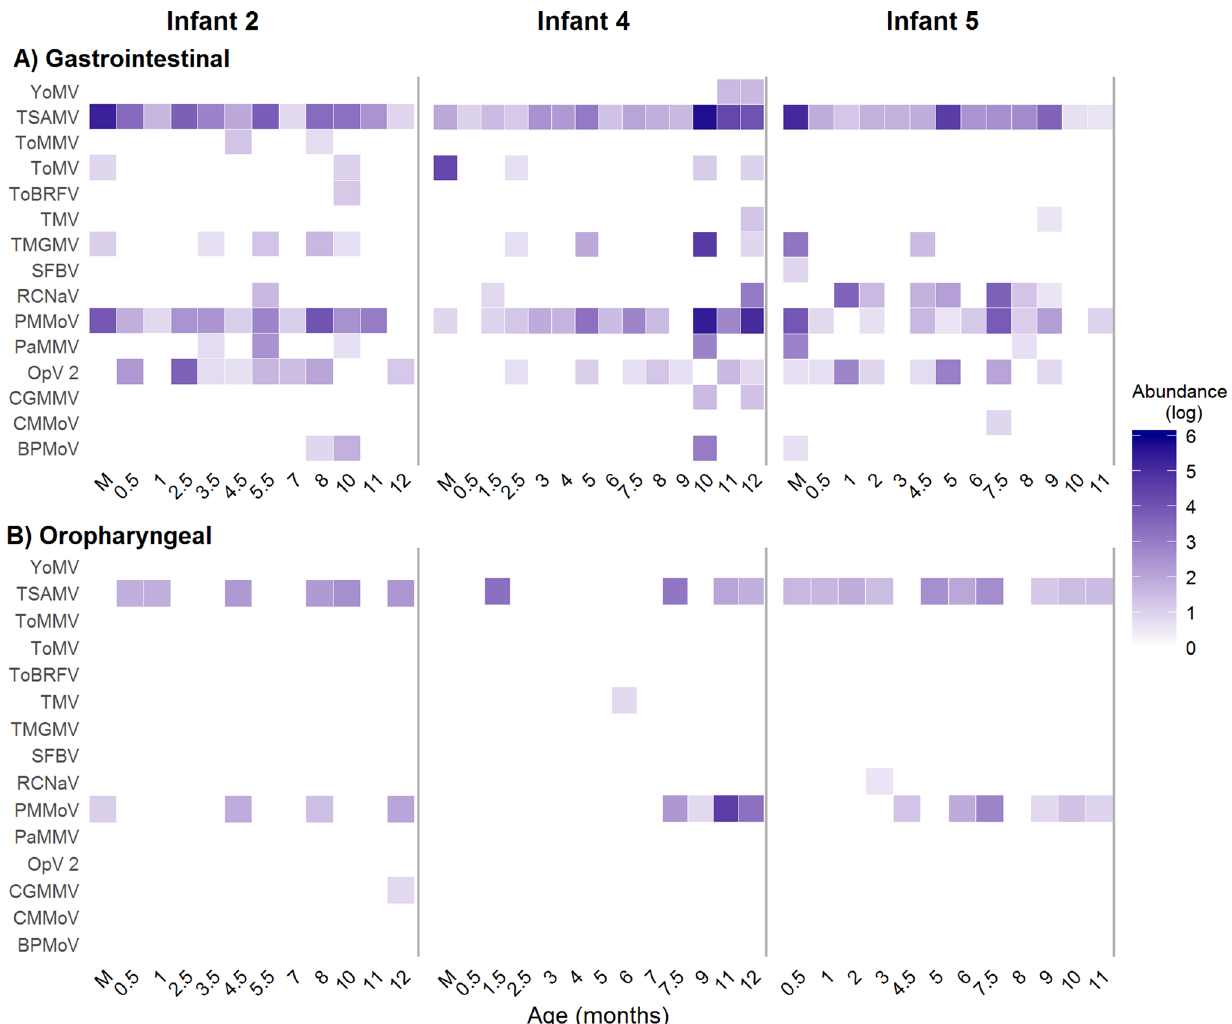
Figure 4. Abundance of tobamovirus species along the first year of life. ( A ) Gastrointestinal samples and ( B ) oropharyngeal samples. Sequence reads were normalized according to the total number of reads after quality filtering. The abundance is represented in a logarithmic scale (log10). M, sample from the corresponding mother. YoMV youcai mosaic virus, TSAMV tropical soda apple mosaic virus, ToMMV tomato mottle